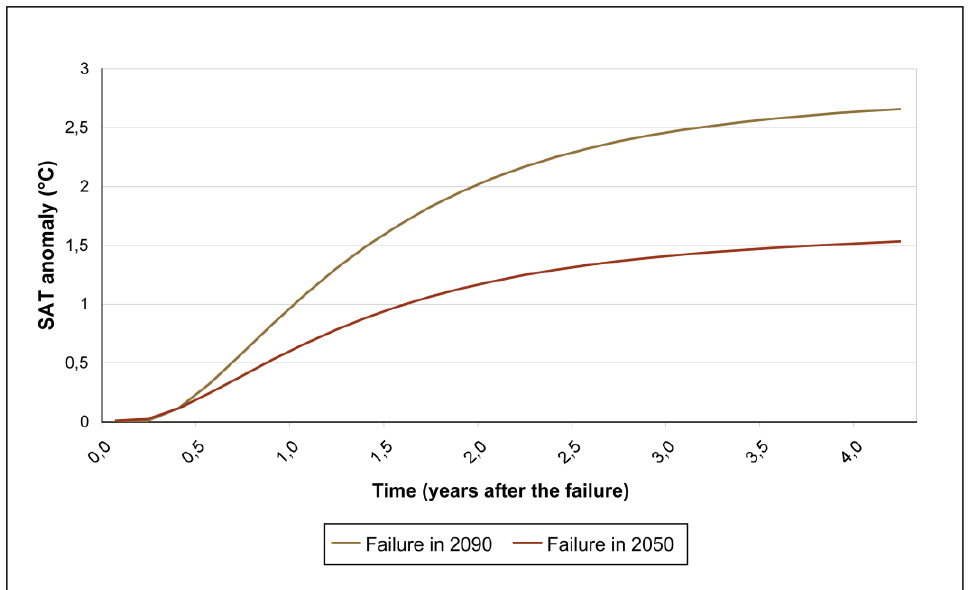
Figure 5. Globally averaged SAT warming after geoengineering failures at 2050 and 2090 with a constant loading equivalent to half of the Mount Pinatubo‘s